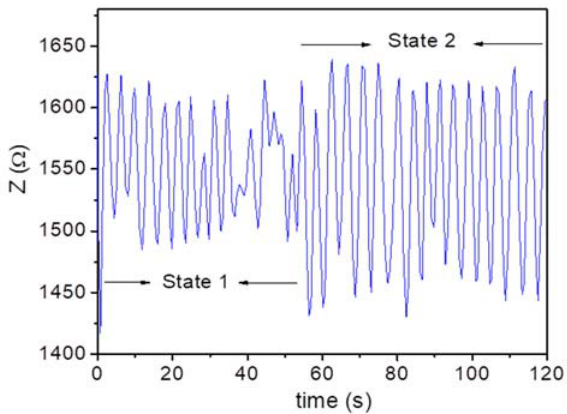
Figure 4. Breathing patterns of Subject 1 (30 years old (YO)) in normal (State 1) and deep (State 2) breathing states. The sensor provided an accurate measure of the strength of breath at these two states. An obvious breathing transition from the first to the second state is observed.